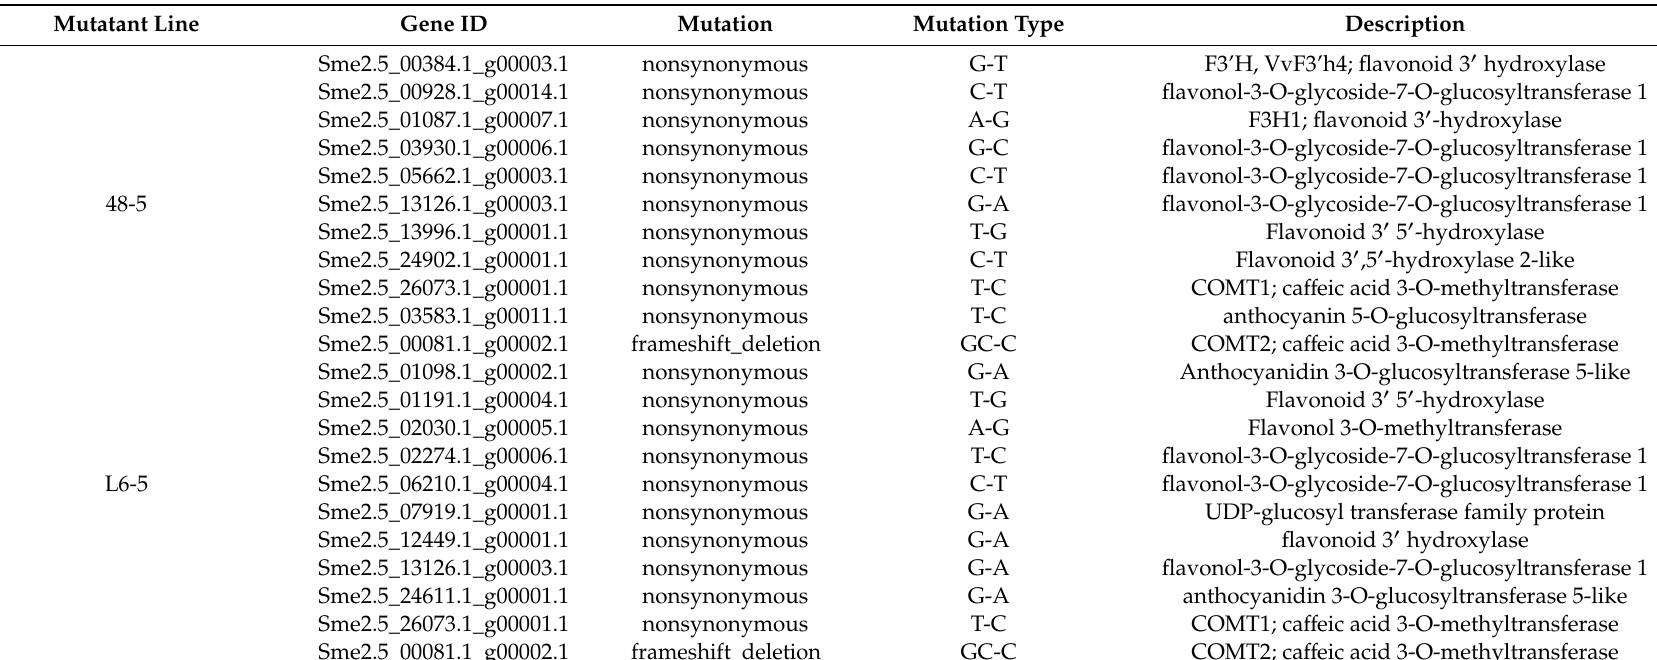
Table 5. The high-impact mutation gene involved in the flavone and flavonol biosynthesis pathway. Mutatant